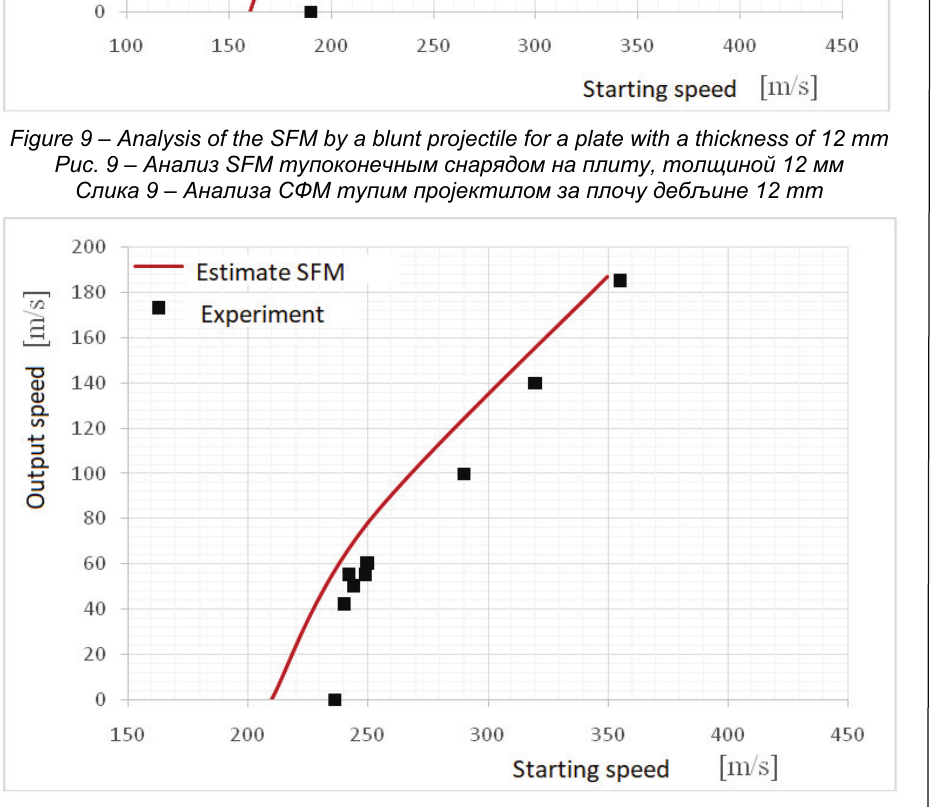
Figure 10 – Analysis of the SFM by a blunt projectile for a plate with a thickness of 16 mm Рис . 10 – Анализ SFM тупоконечным снарядом на плиту , толщиной 16 мм Слика 10 – Анализа СФМ тупим пројектилом за плочу дебљине 16